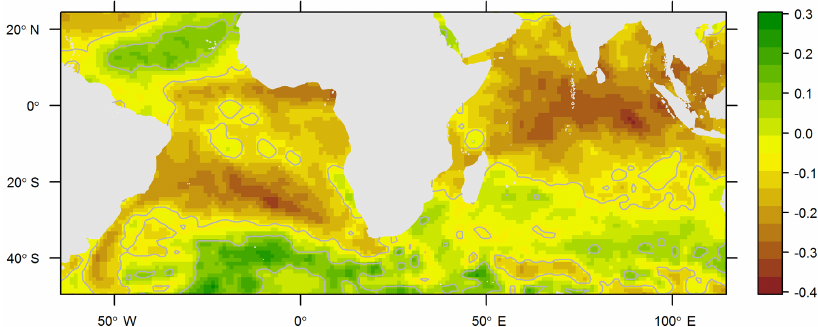
Figure 4. Correlation of standardised streamflow (6-month scale) of station Chokwe and sea surface temperature anomalies; grey contours indicate significance at